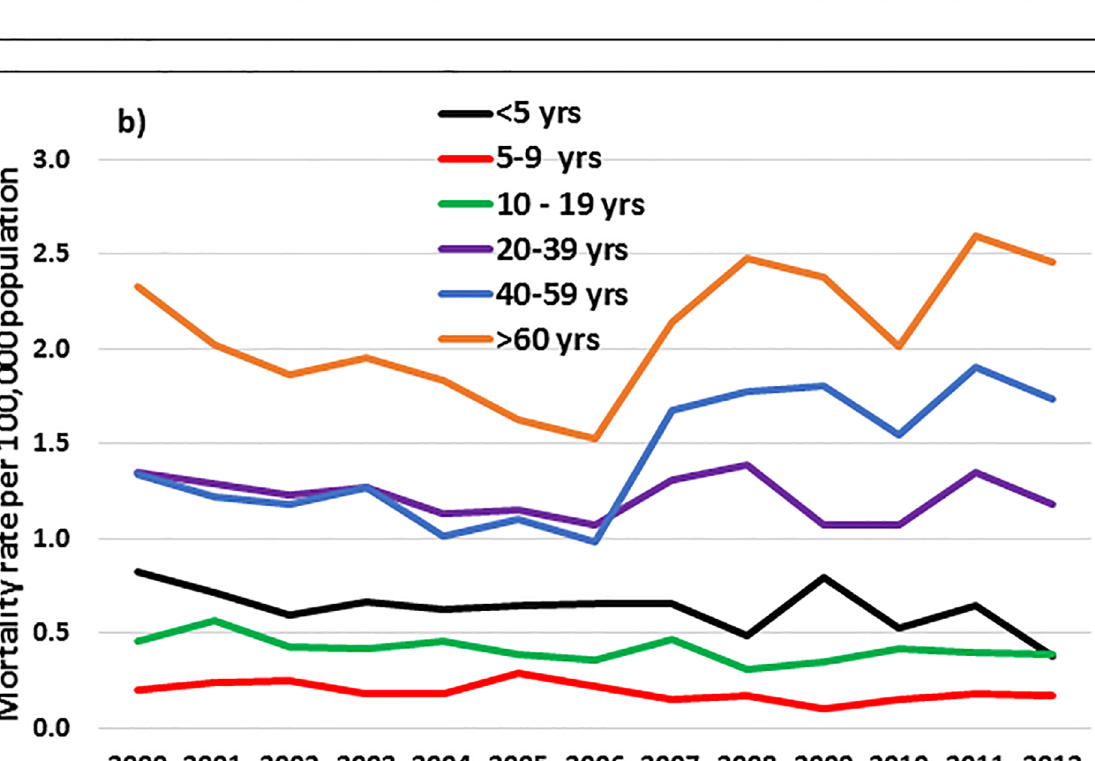
PLOS ONE | https://doi.org/10.1371/journal.pone.0181708 July 20,